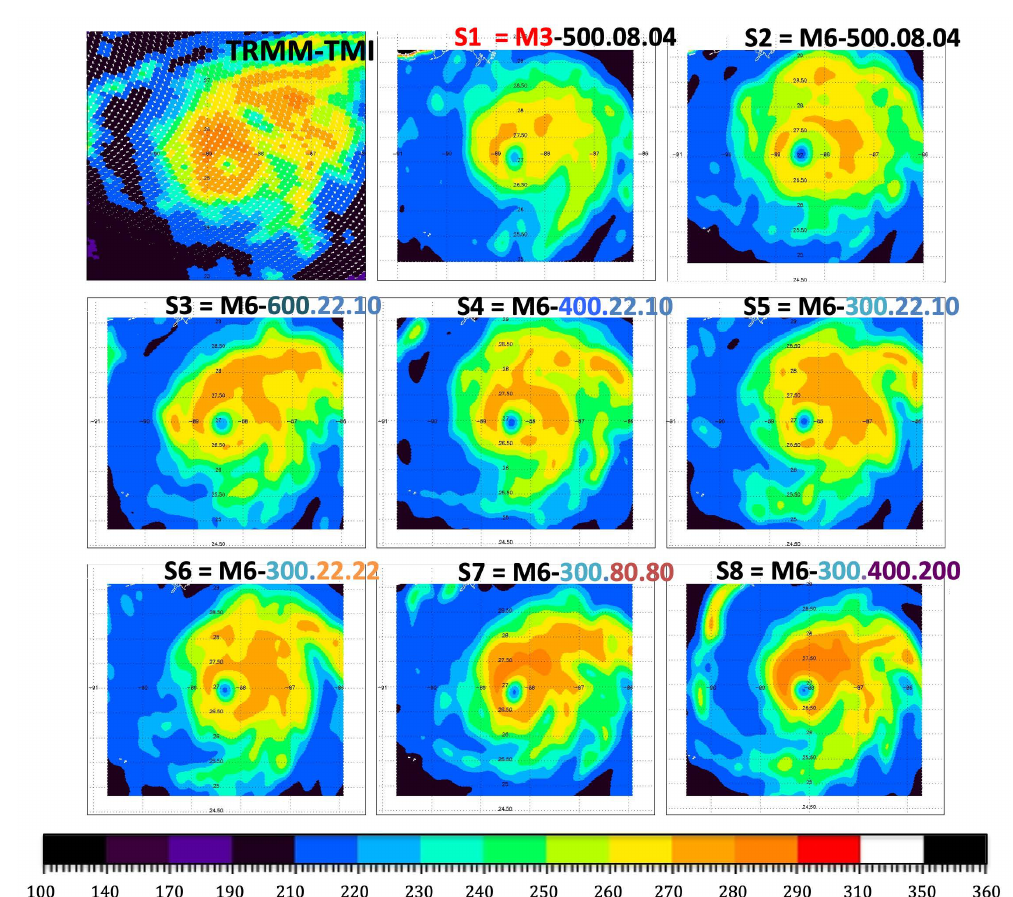
Figure 7. Comparison of observed (top left) and simulated 19 GHz brightness temperatures for each of the 8 simulated storms. The synthetic data are shown at the spatial resolution of the observations, after averaging the data produced initially at the high model resolution. The panels are arranged similarly to these in Figure 3, with the exception of the top-left panel where the observations are presented. As in Figure 3, the color in the title of the remaining eight subfigures represents the following selections: (i) sensitivity to microphysics: M3 is in red, M6 is in black; (ii) sensitivity to assumed density of graupel: (cid:36) = 600 kg/m 3 in dark blue, 400 in navy blue, 300 in light blue; (iii) sensitivity to the impact of the intercept parameters for rain (N 0r ) and graupel (N 0g ): N 0r = 22 × 10 6 m − 4 and N 0g = 22 × 10 6 m − 4 —in light orange, N 0r = 80 × 10 6 m − 4